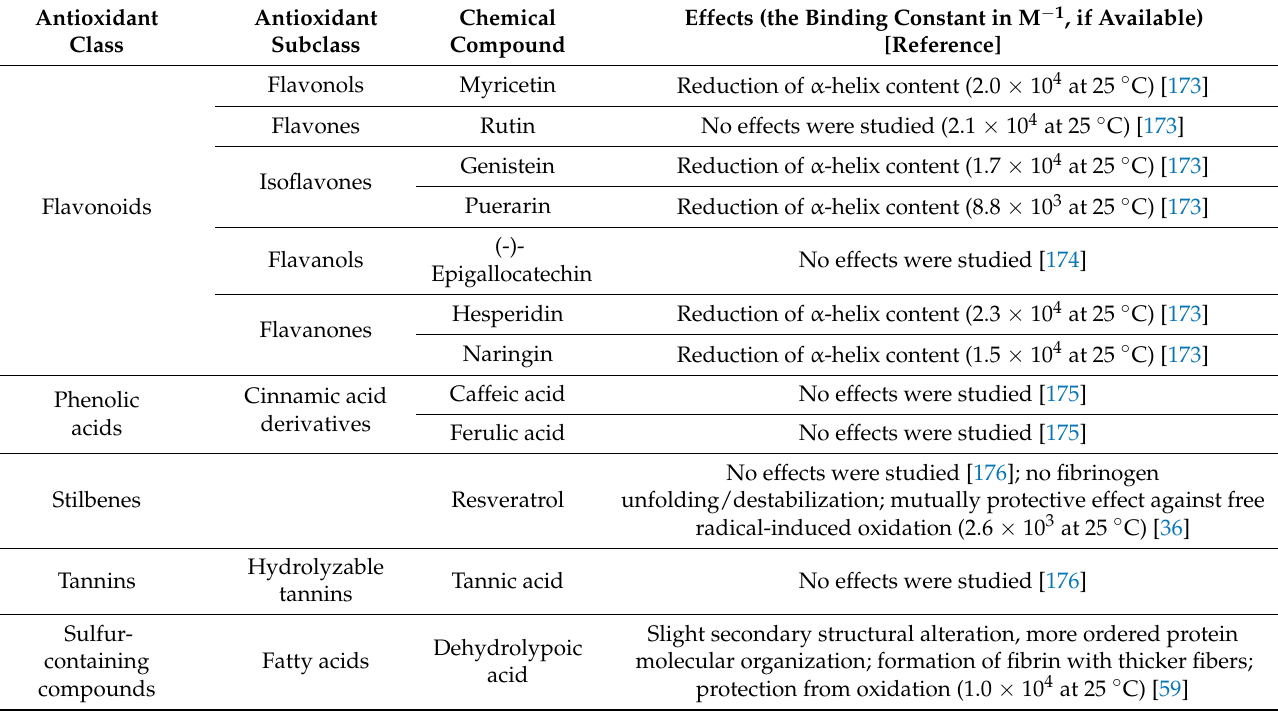
Table 4. Known interactions between food antioxidants and human fibrinogen.